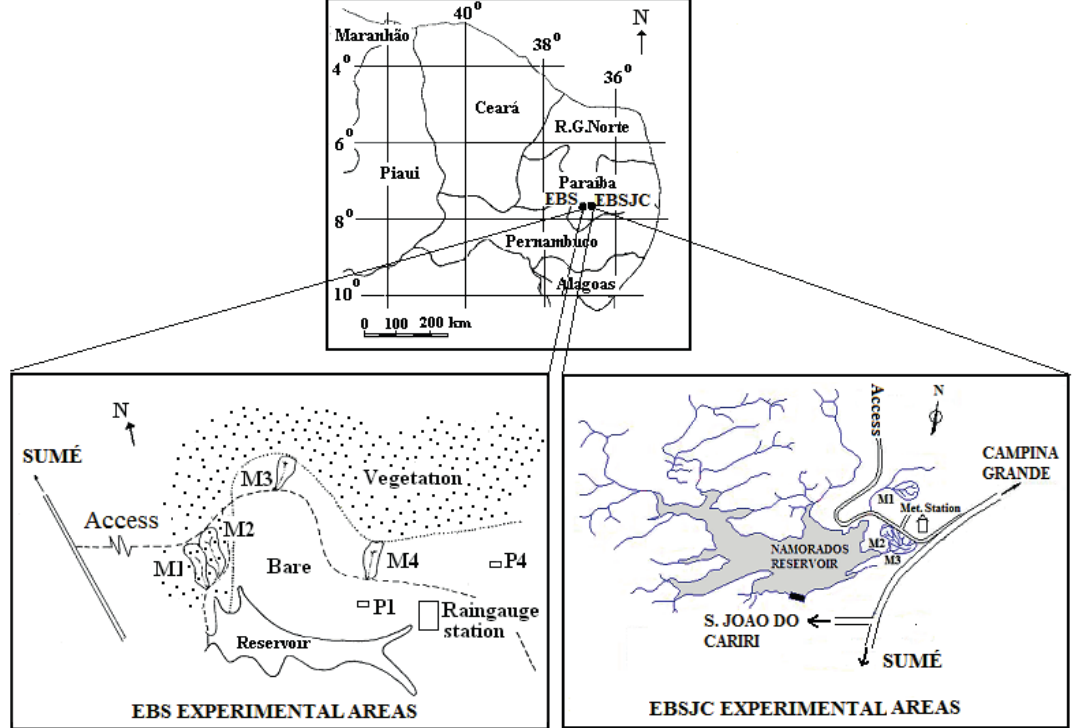
Fig. 1 EBS and EBSJC experimental areas of Sumé and São João do Cariri (adapted from Figueiredo & Bathurst, 2006; and FINEP,